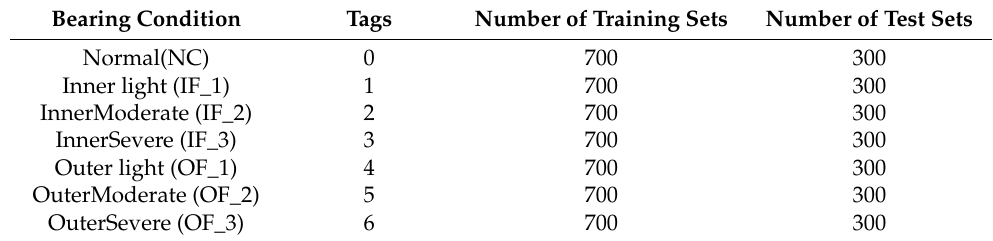
Table 6. SQV variable speed bearing sample distribution.